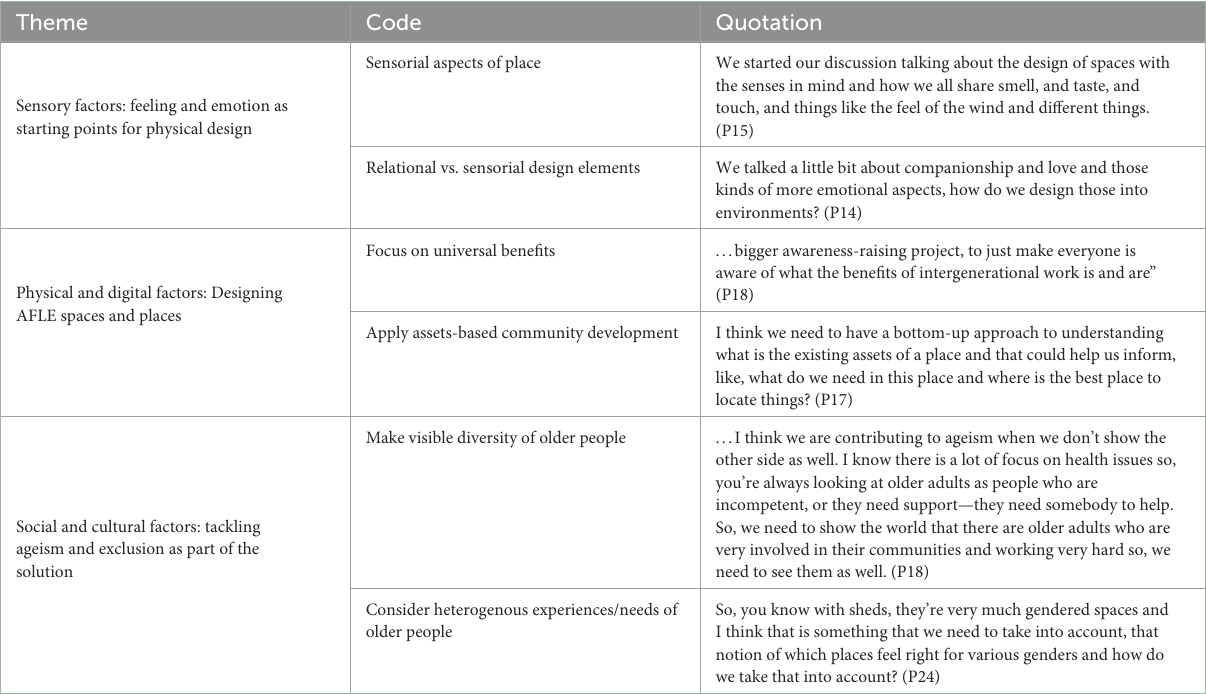
TABLE 3 Snapshot of thematic analysis coding structure and